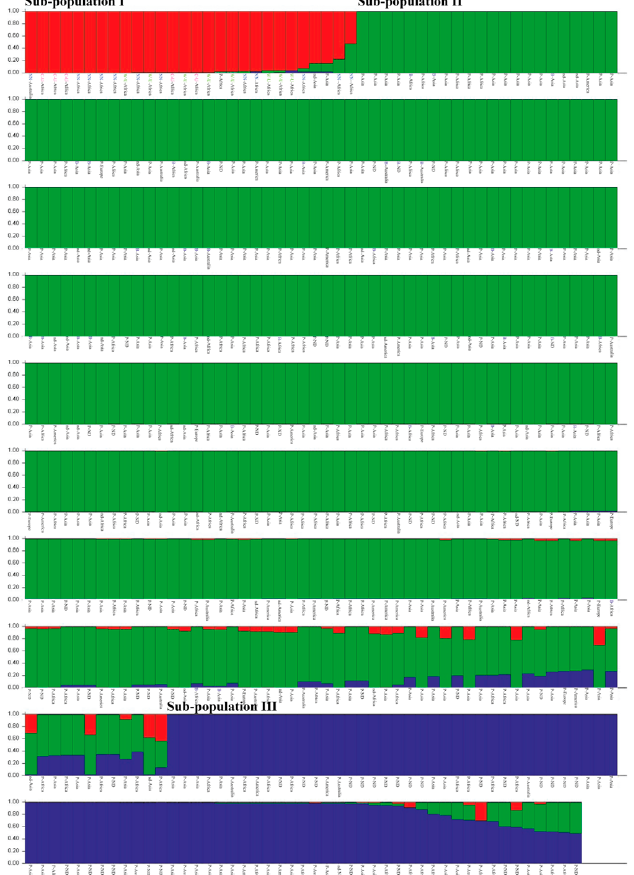
Figure 1. Population structure of the 493 lablab accessions determined by STRUCTURE analysis based on 15 nuclear SSR markers. Each bar represents one individual. B = spp. bengalensis , P = spp. purpureus , C-U = cultivated spp. uncinatus , W-U = wild spp. uncinatus , NN = wild ssp. nomen nominandum , and ND = not determined.